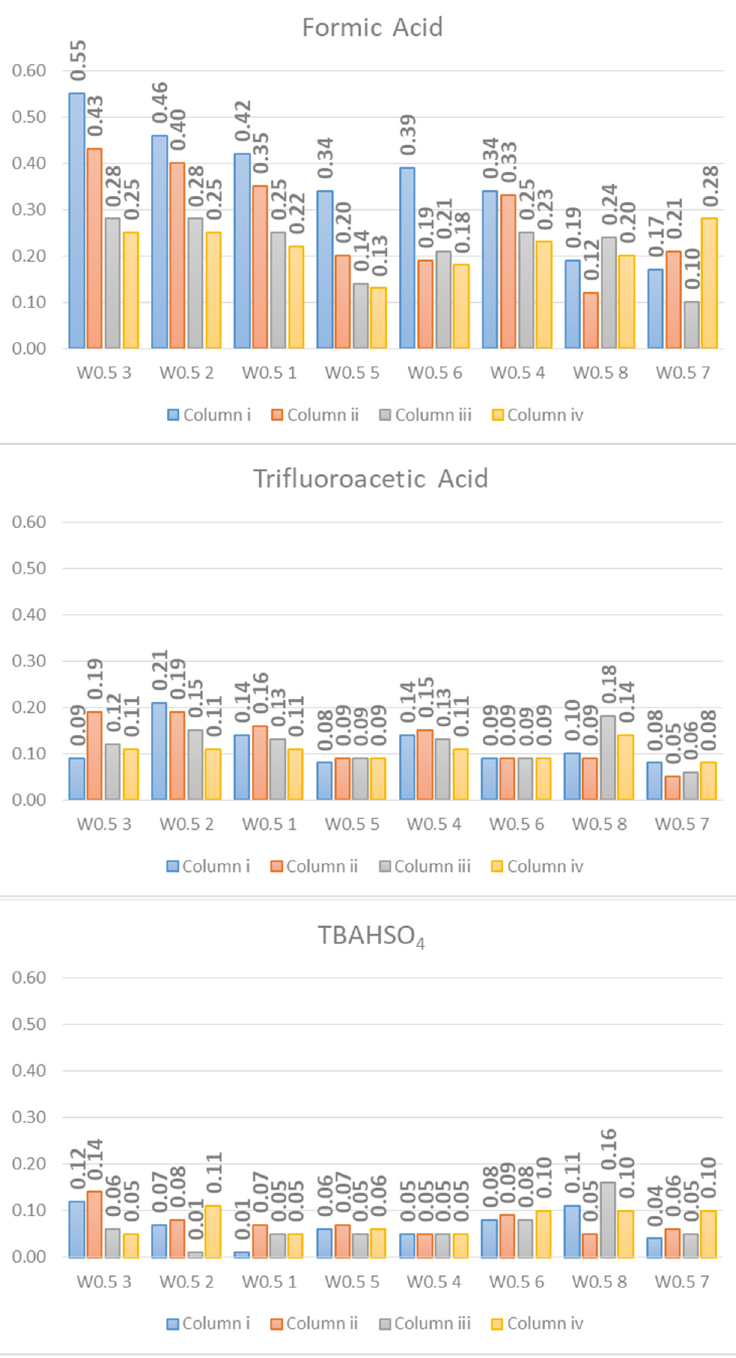
Figure 5. Peak Width at Half-Height ( W 0.5 ).